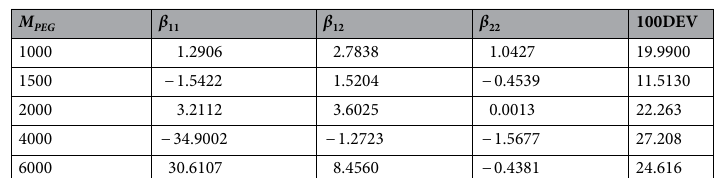
Table 6. Results of the correlation of the experimental tie-line compositions using the osmotic virial equation for PEG